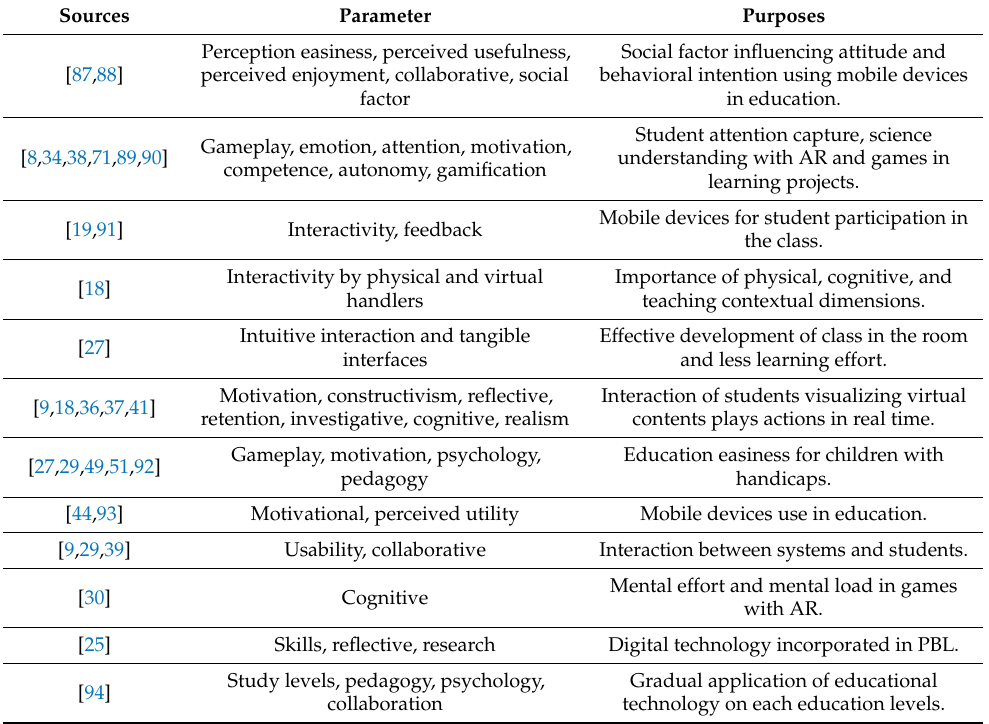
Table 3. Parameters used in various research